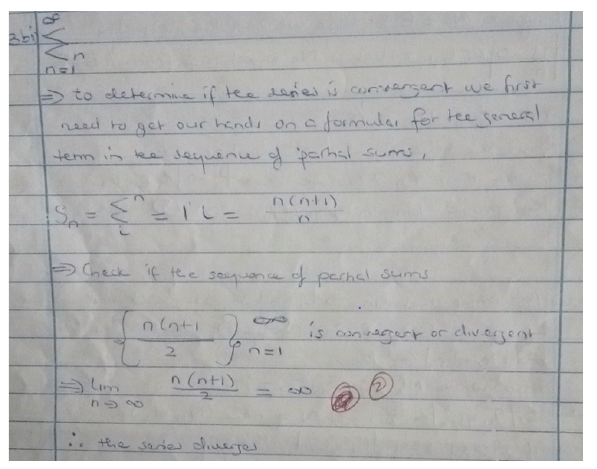
FIG URE 4: Written response of ST28 to task 1b